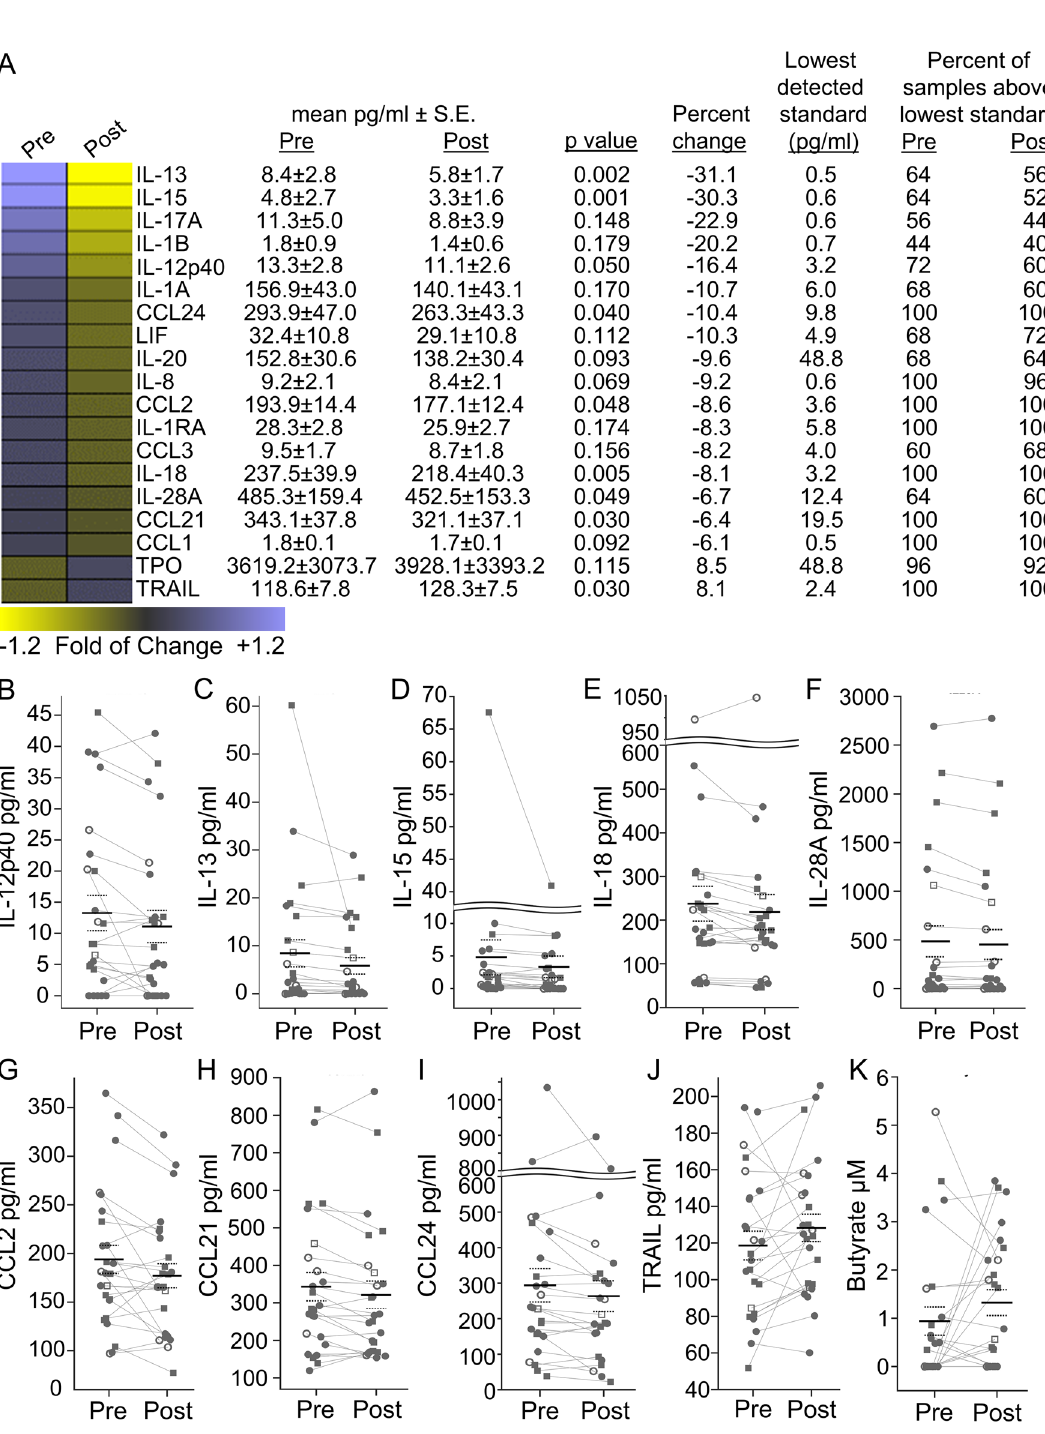
Figure 3. Levels of plasma borne mediators before and after probiotic supplementation. ( A–J ) Plasma samples of 25 sibling participants were assayed in duplicate before and after supplement by ELISA. In ( A ) mediators that exhibited an absolute change of more than 5% after supplement with a p-value < 0.2 are tabulated. Significant reductions in IL-12p40, IL-13, IL-15, IL-18, IL-28A, CCL2/MCP1, CCL21/C6kine, and CCL24/eotaxin 2 were observed, while TRAIL exhibited a significant increase (paired Wilcoxon rank sum test). These significantly modulated mediators are plotted in ( B–J ). Additional analytes were included in the panel (CRP, EGF, CCL11, FGF-2, Flt-3 ligand, fractalkine, G-CSF, GM-CSF, GRO, IFN-α2, IFN-γ, IL-10, IL-12p70, IL-17A, IL-1ra, IL-1α, IL-1β, IL-2, IL-3, IL-4, IL-5, IL-6, IL-7, IL-8, IL-9, IP-10, MCP-3, CCL22, MIP-1α, MIP-1β,